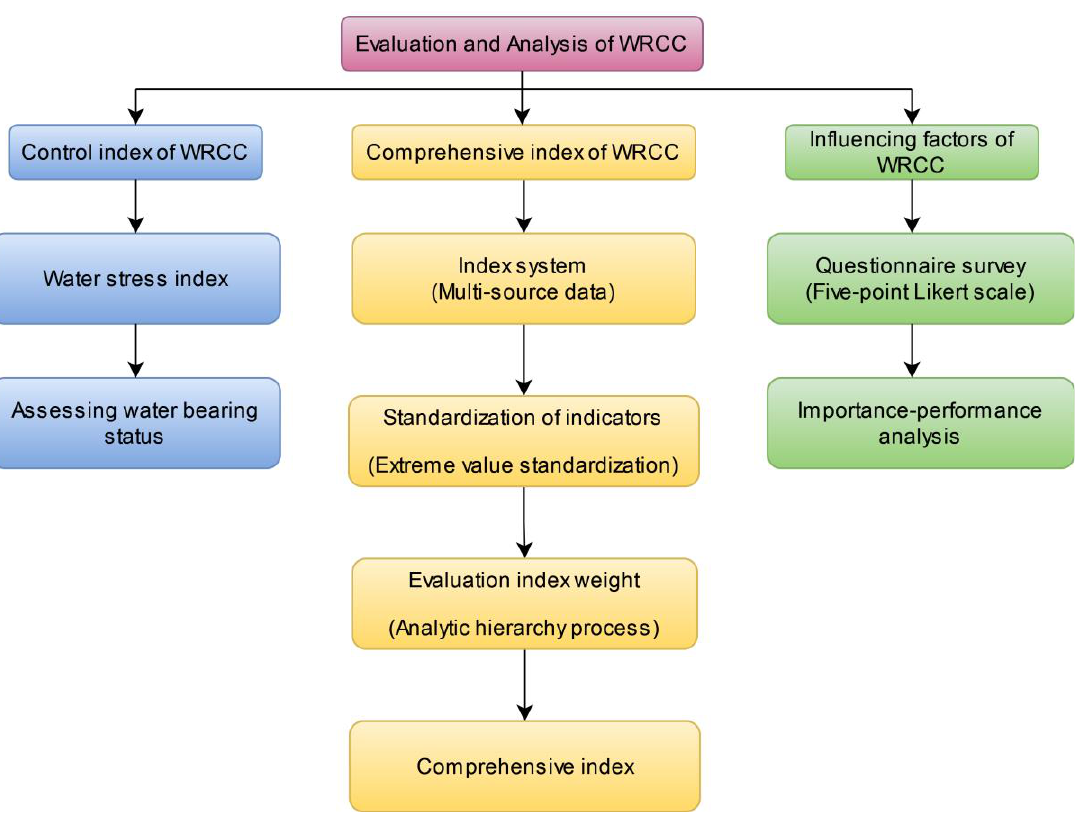
Figure 3. Flow chart of WRCC assessment methodology. Table 3. Evaluation criteria for control index of water resources carrying capacity in